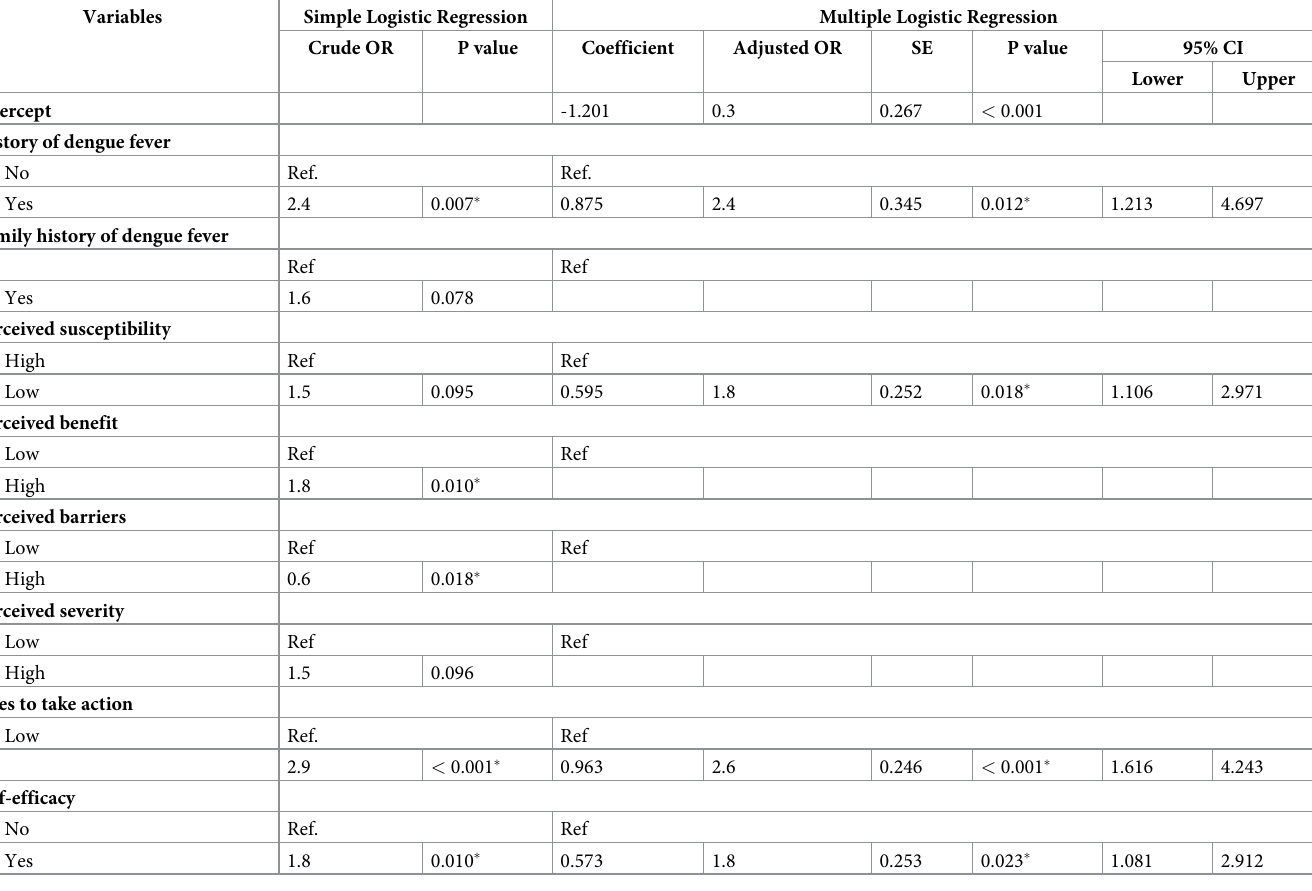
Table 3. Associations of good dengue preventive practices among residents in Taman Kota